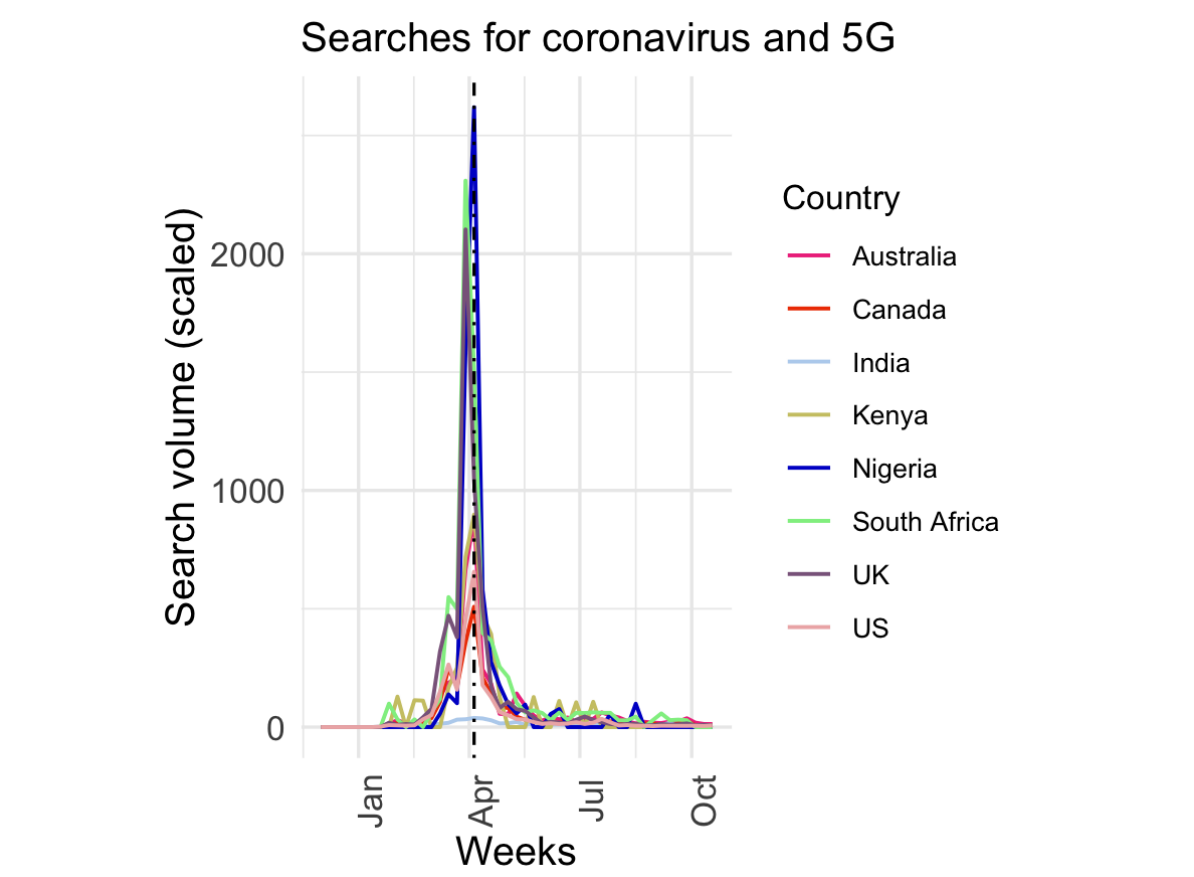
Figure 1. Trends in searches for coronavirus and 5G across 8 countries from December 2019 to October 2020. The black vertical line indicates the time the World Health Organization included the topic on the Mythbusters